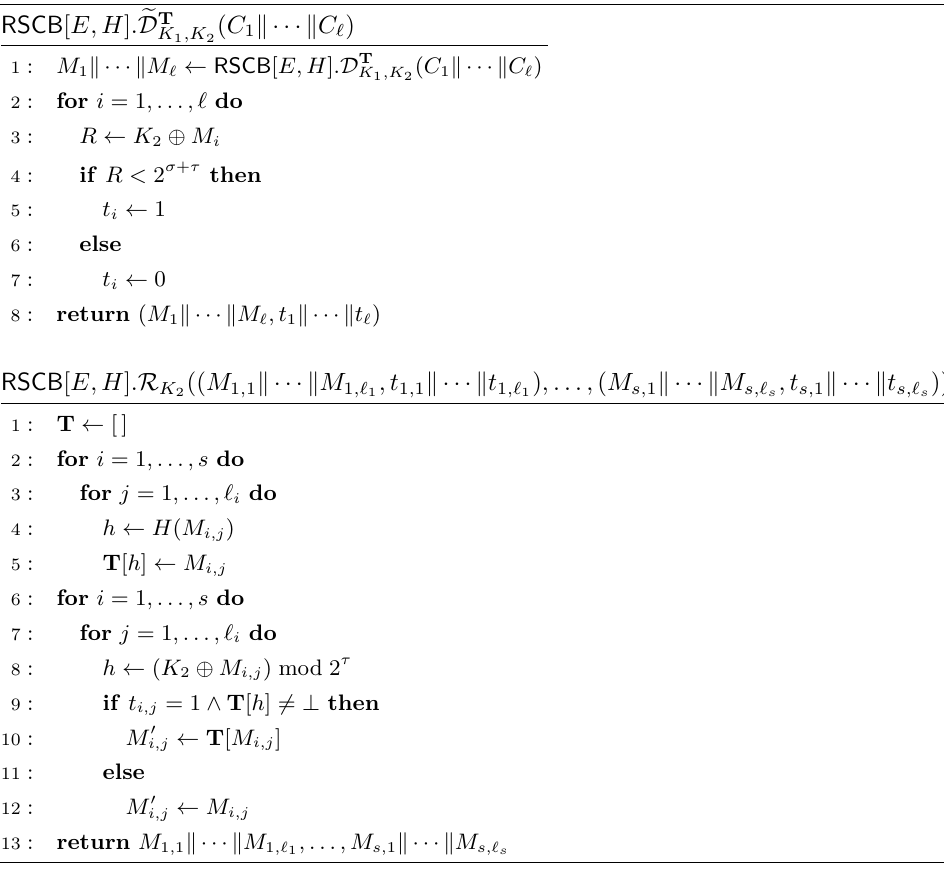
Figure 12: Tagged decryption and recovery algorithms of RSCB [ E, H ]. Note that R does not use K , so we slightly abused notation in the function 1